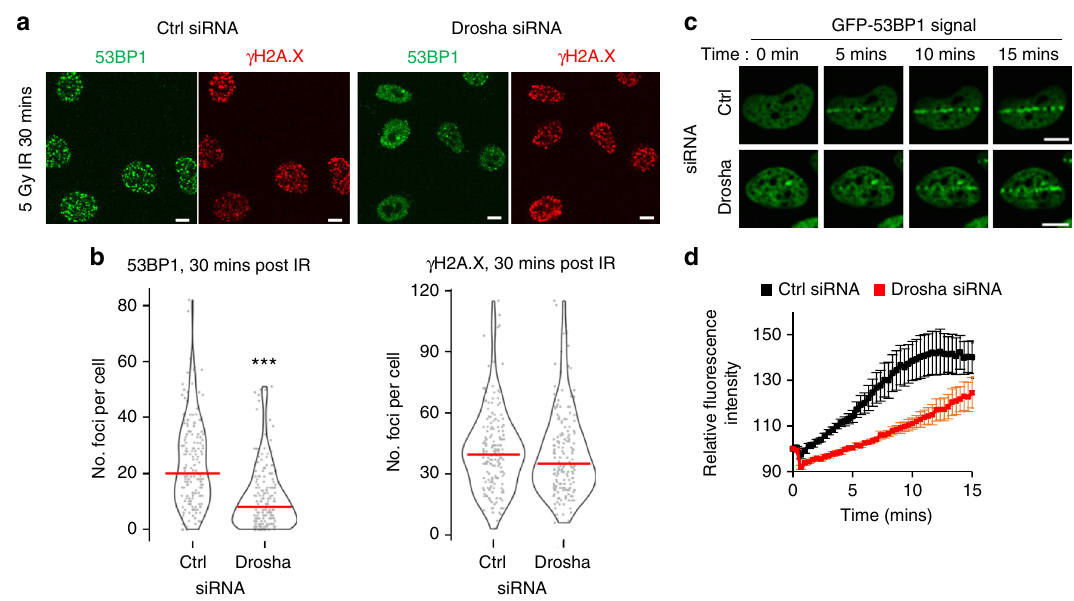
Fig. 3 Drosha is required for early 53BP1 localization after DNA damage. a Representative immuno fl uorescence image of IR-induced 53BP1 foci in A549 cells, 30 mins post 5 Gy IR. Scale bars, 10 µ m. b Drosha knockdown signi fi cantly impairs 53BP1 foci formation as early as 30 minutes after 5 Gy IR. Violin plots and data points show quanti fi cation, as in Fig. 1B, of IR-induced 53BP1 and γ H2A.X foci shown in a . 200 cells were counted across 3 biological replicates, *** p ≤ 0.001, Mann-Whitney non-parametric test. c U2OS cells expressing GFP-53BP1 were subjected to laser microirradiation and GFP redistribution was monitored in real time. Images of selected time points post microirradiation are shown. d Quanti fi cation of time-course as in c , error bars = SEM, n ≥ 30 cells per condition over 4